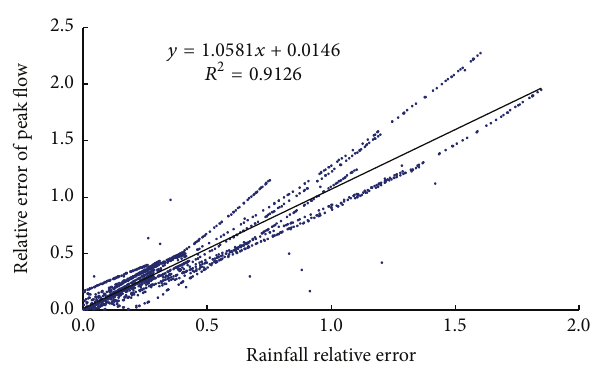
Figure 6: Relationship between error in predicted flood peak time and rainfall relative